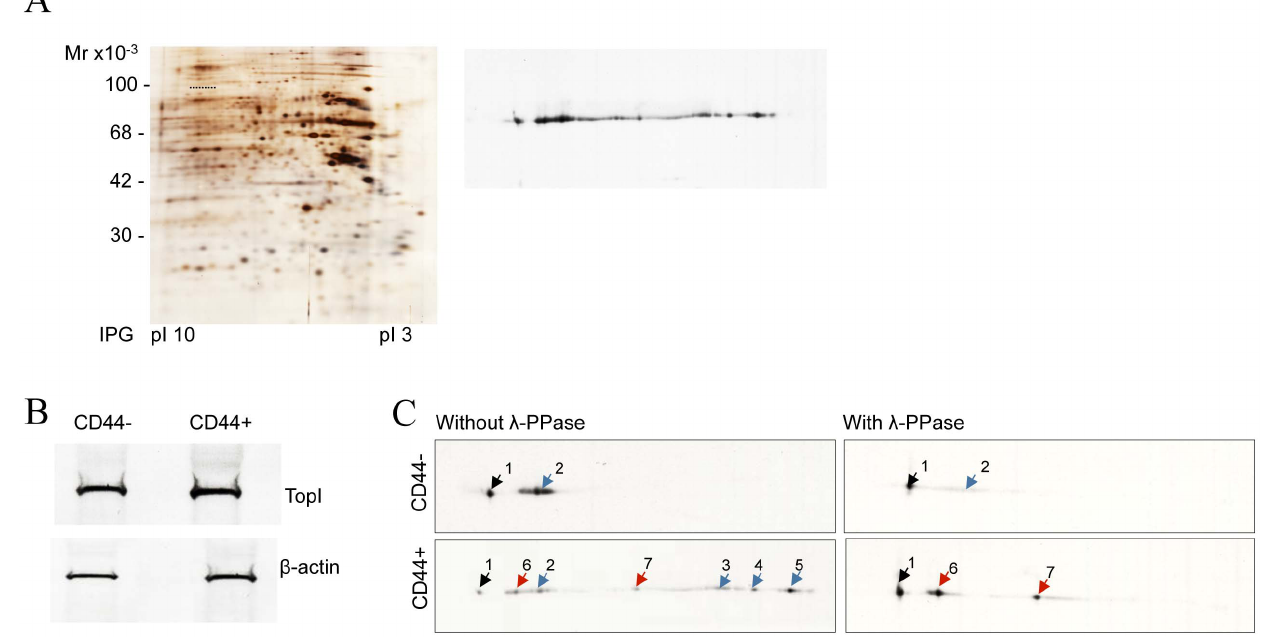
Figure 3. Phoshorylation pattern of TopI in extracts from CD44 + or CD44 2 cell subpopulations. ( A ) Two-dimensional silver staining (left panel) and immunoblot analysis (right panel) of TopI expression pattern in the Caco2 cell line. The positions of TopI are underlined. The TopI identity of two major isoforms recognized by TopI antibodies was ensured by the MS/MS analysis of several bands excised from the silver stained gel (data not shown). ( B ) One-dimentional immunoblot analysis of TopI expression in CD44 2 and CD44 + FACS sorted cell fractions by immunoblotting with TopI antibodies. b -actin was used as a loading control. ( C ) Two-dimentional immunoblot analysis of TopI expression and post-translational modification pattern in CD44 2 and CD44 + cell fractions (left-hand panels) by immunoblotting with TopI antibodies. Equal protein amounts were loaded on the gels. The time of blot exposure is identical. The resulting pattern of TopI after cell treatment with l -PPase prior the 2D PAGE analysis is presented (right-hand panels). Arrowheads indicate multiple forms of TopI (black arrowheads – the position of the non-phosphorylated TopI, blue arrowheads – the positions of phosphorylated TopI isoforms; red arrowheads – the positions of non-phosphorylated otherwise modified isoforms). The positions of parental and modified TopI isoforms are verified by the superimposing of all analyzed